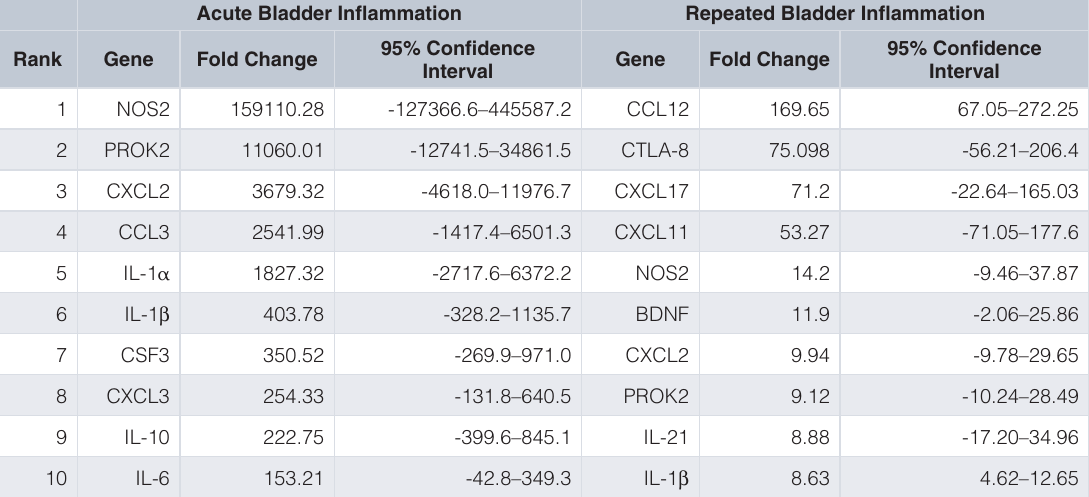
Table 3. Top 10 up-regulated transcripts in bladder tissue from turpentine group, ranked by mRNA fold change normalised to naive values. Data presented as mean fold change (95% confidence interval), n=3–4